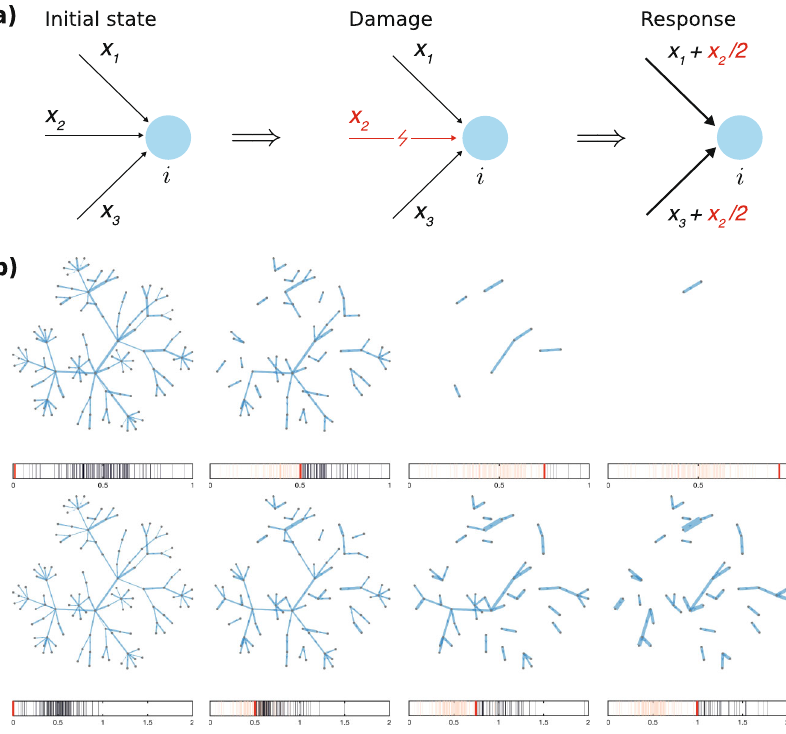
Fig. 1 Simple fi ltration vs. fi ltration with homeostatic response. a Pictorial representation of the damage – response process for a given node i . Here, in the damaged state, one of the three initial in-edges is removed, hence its weight, w 2 , is equally redistributed among the surviving edges, in order to conserve the local in-strength of the initial state. b Several snapshots illustrating an example of multi-step degradation on a small network, governed by: fi ltration, where every edge is removed if its weight is below a given threshold ( fi rst row), and fi ltration with the homeostatic response that maintains the total weight of in-edges at a constant level (second row). The bars below the panels indicate the distribution of edge weights ( black ) and the value of the threshold red .